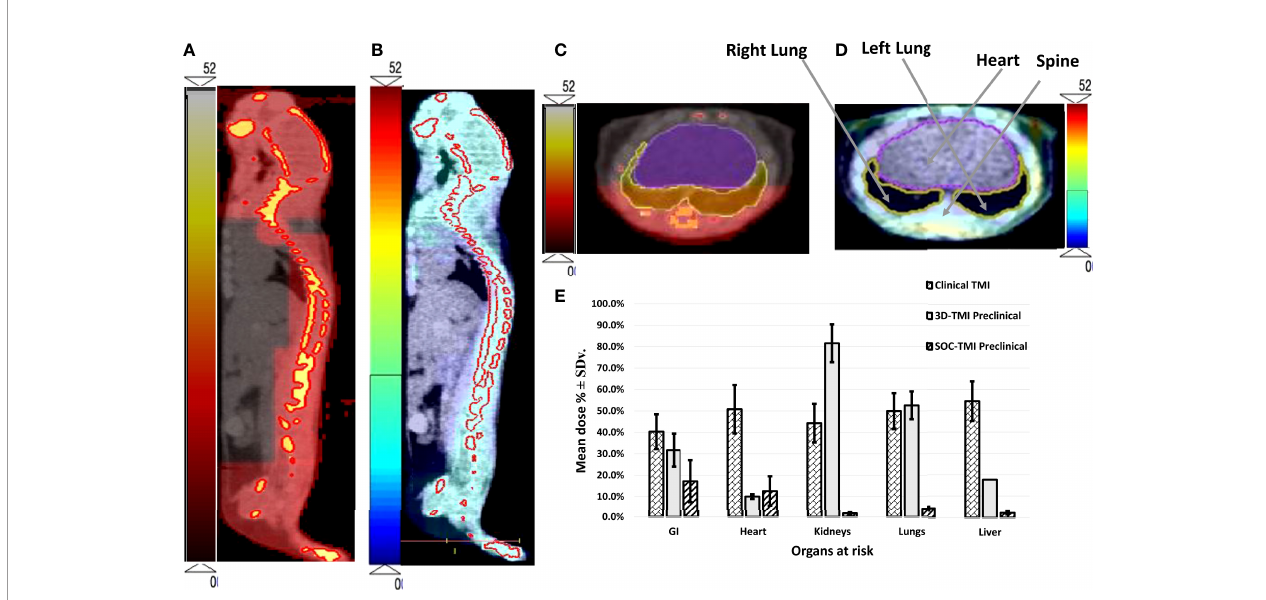
FIGURE 3 | The dose distribution of both (A) 3D-TMI preclinical model and (B) SOC-TMI preclinical model. (C, D) Identical axial CBCT image obtained at the level of the lungs of mouse shows conformal dose distribution for spine, ribs, and sternum for both SOC-preclinical and 3D-preclinical model, respectively. (E) Bar chart shown for critical organs — GI, heart, kidneys, lungs, and liver. Three bars in each group represent the mean dose for average of six clinical TMI studies, 3D-TMI preclinical, and SOC-TMI